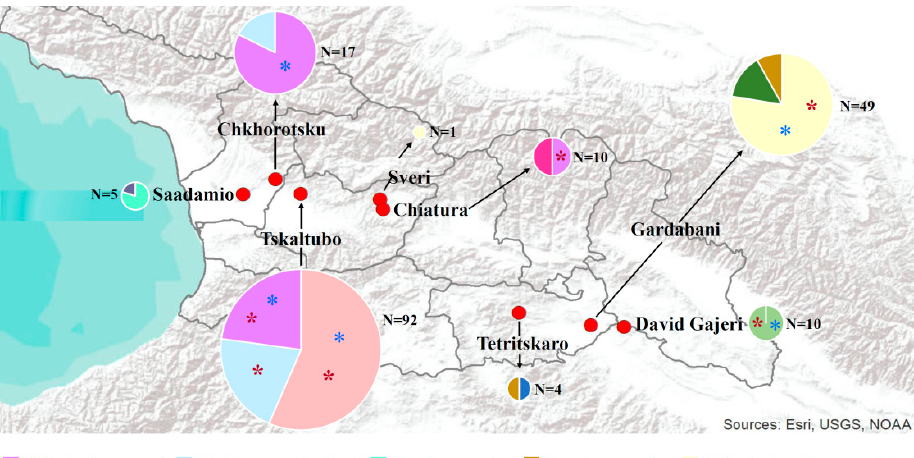
Figure 1. Geographic location and relative proportion of bat species collected per collection site. Red circles indicate the approximate location of collection site. Pie charts indicate the relative proportion of each bat species collected per site. Size of the pie charts indicates the relative number of samples collected per site. Asterisks within the pie indicate whether individuals of that species tested positive for alpha (red) and/or beta CoVs (blue). Lack of asterisks indicates no CoV were detected in a bat species and/or site. Color codes for each bat species represented in the pie charts are indicated in the lower part of the figure.